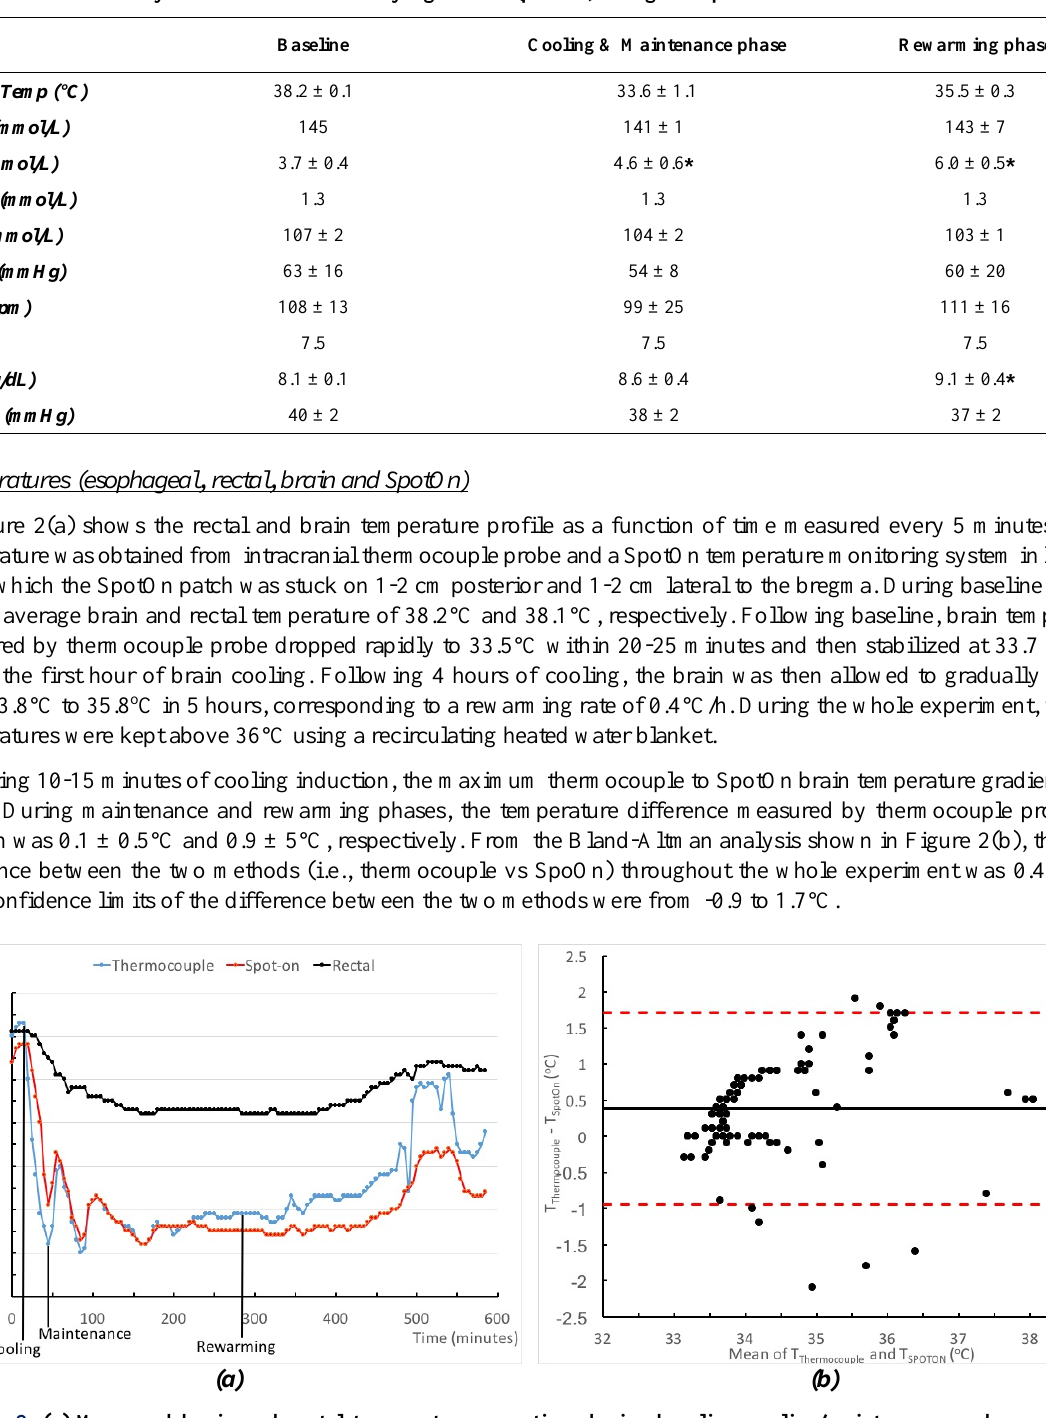
Figure 2. (a) Measured brain and rectal temperature over time during baseline, cooling/maintenance and rewarming phase. Brain data were obtained from thermocouple needle probe and SpotOn temperature monitoring system in location #1, in which the SpotOn patch was stuck on 1-2 cm posterior and 1-2 cm lateral to the bregma. (b) Bland-Altman plot of two brain temperature methods. The dotted line shows the mean difference and dash-dotted lines show the limits of agreement (mean ± 2